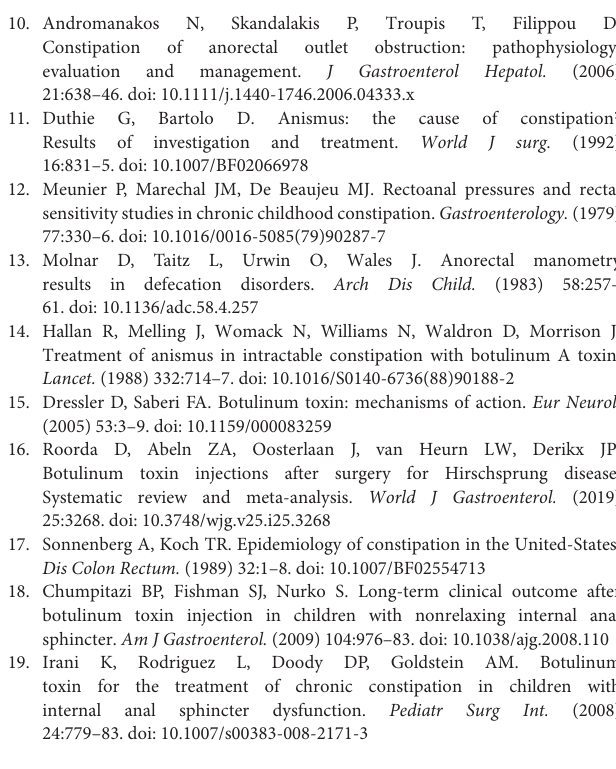
Supplementary Figure 1 | The administration of the botulinum toxin injections. (A) Injections were administered in four quadrants; (B) injection migratory direction and distance; (C) measurement of anal canal pressure with manometry. Supplementary Figure 2 | The 2D map representing graphical outcome of anal canal pressure measured with manometry from one patient. (A) Before injection, the anal canal pressure was high; (B) after injection anal canal pressure has decreased. Supplementary Table 1 | Correlation analysis † between the variables taken into the multivariable linear regression analysis in cases with idiopathic constipation